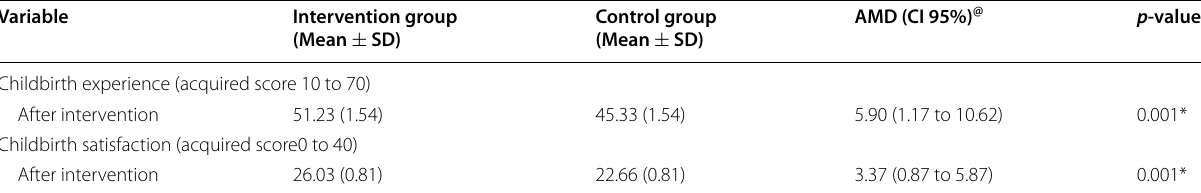
*ANCOVA test with control of baseline values. @ adjusted mean difference (confidence interval of